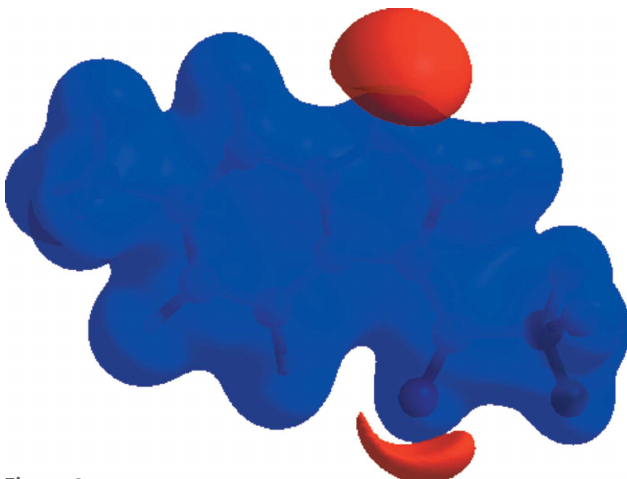
Figure 8 View of the three-dimensional Hirshfeld surface of the title molecule plotted over electrostatic potential energy in the range (cid:4) 0.0500 to 0.0500 a.u. calculated at the Hartree–Fock level of theory using the STO-3 G basis set. Hydrogen-bond donors and acceptors are shown as blue and red regions around the atoms, corresponding to positive and negative potentials, respectively.